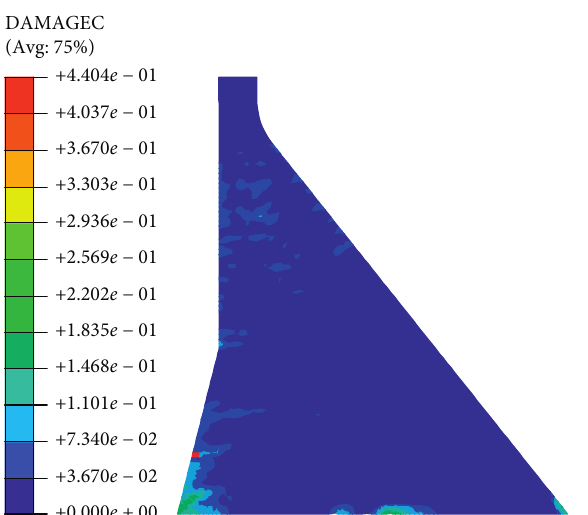
Figure 19: The compression damage-rupture distribution considering both the tension and compression damage for the overload co- efficient of 3.0.